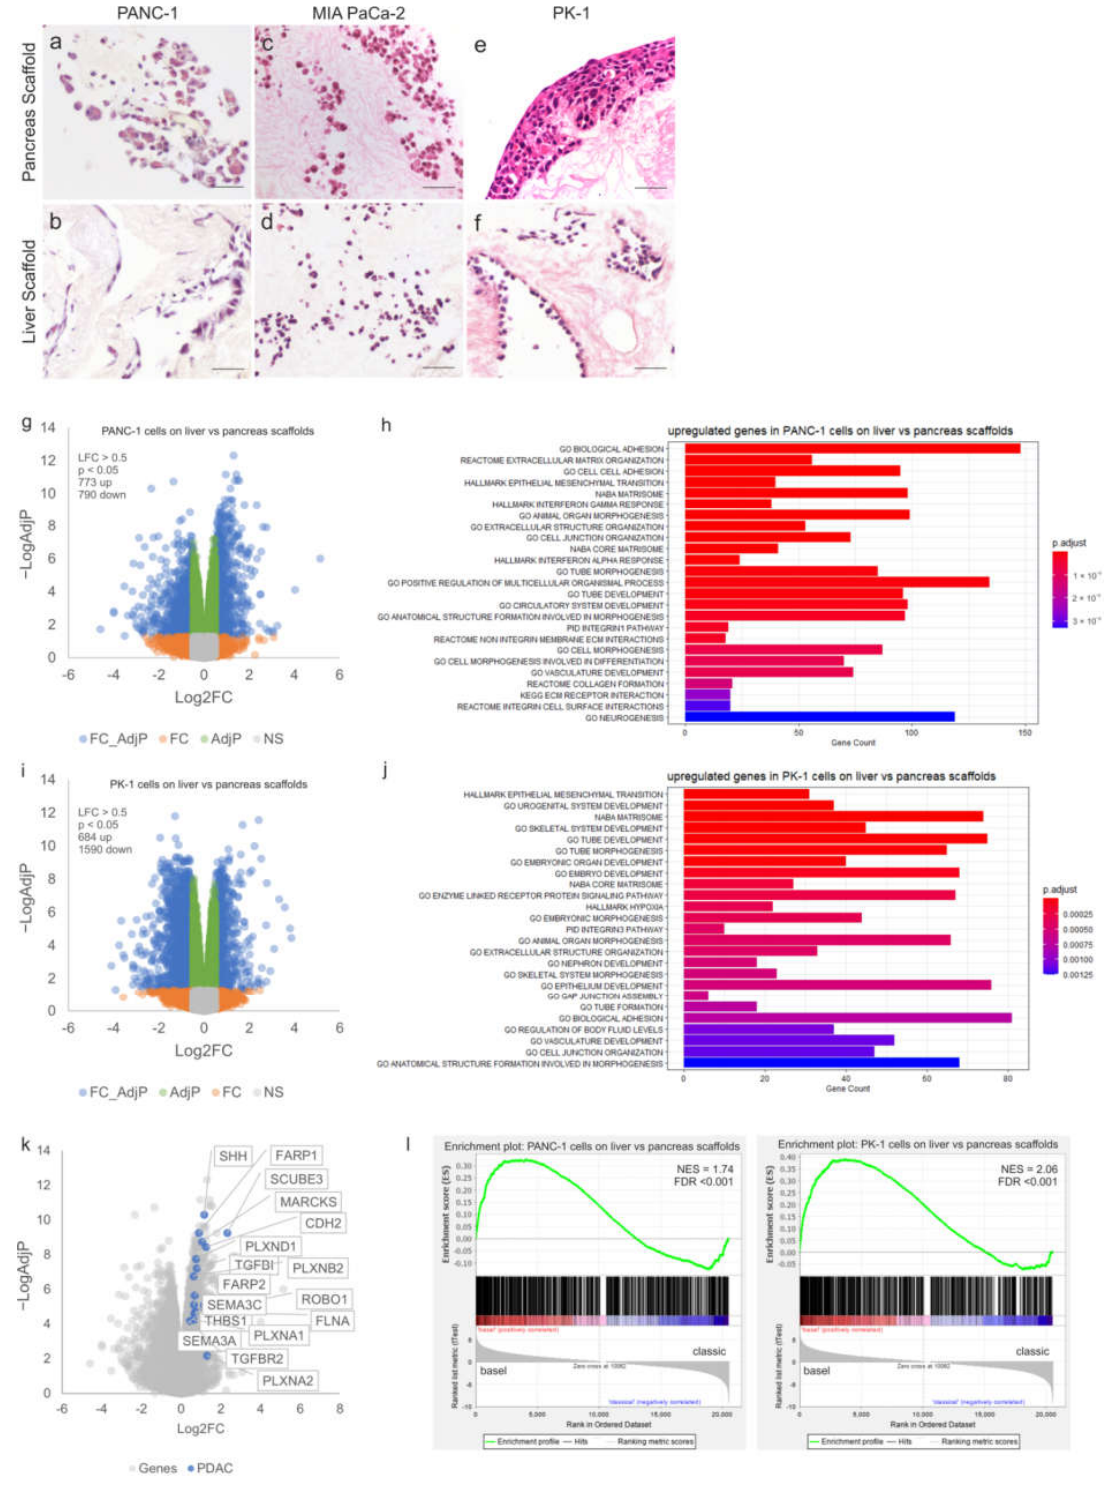
Figure 2. Tissue-specific properties of human decellularized scaffolds for PDAC cultures. H&E staining of PDAC cells cultured for 14 days on decellularized scaffolds showed ( a ) PANC-1 cells on pancreas scaffolds migrated into the ECM and ( b ) PANC-1 cells on liver scaffolds only attached on the edge of the ECM with no migration inward. ( c ) MIA PaCa-2 cells on pancreas scaffolds